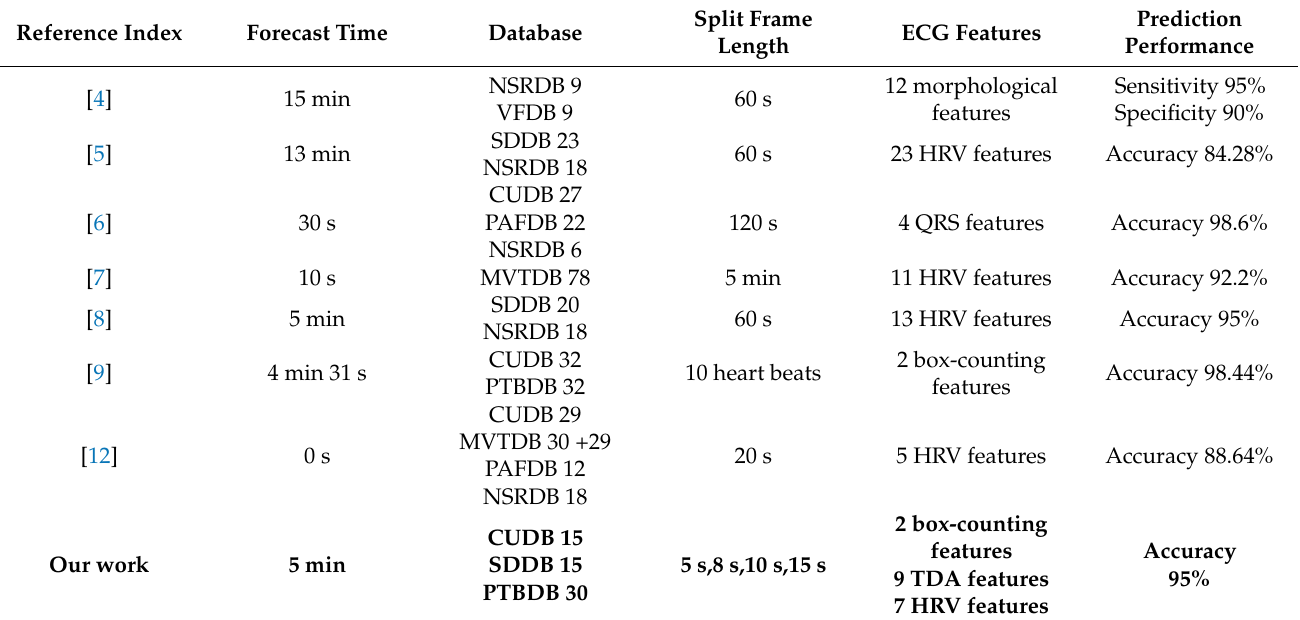
Table 7. List of studies on the ECG-based VF